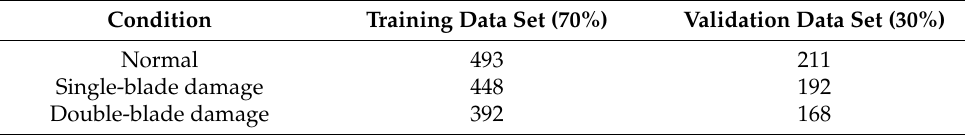
Table 5. Data set composition in training and validation.